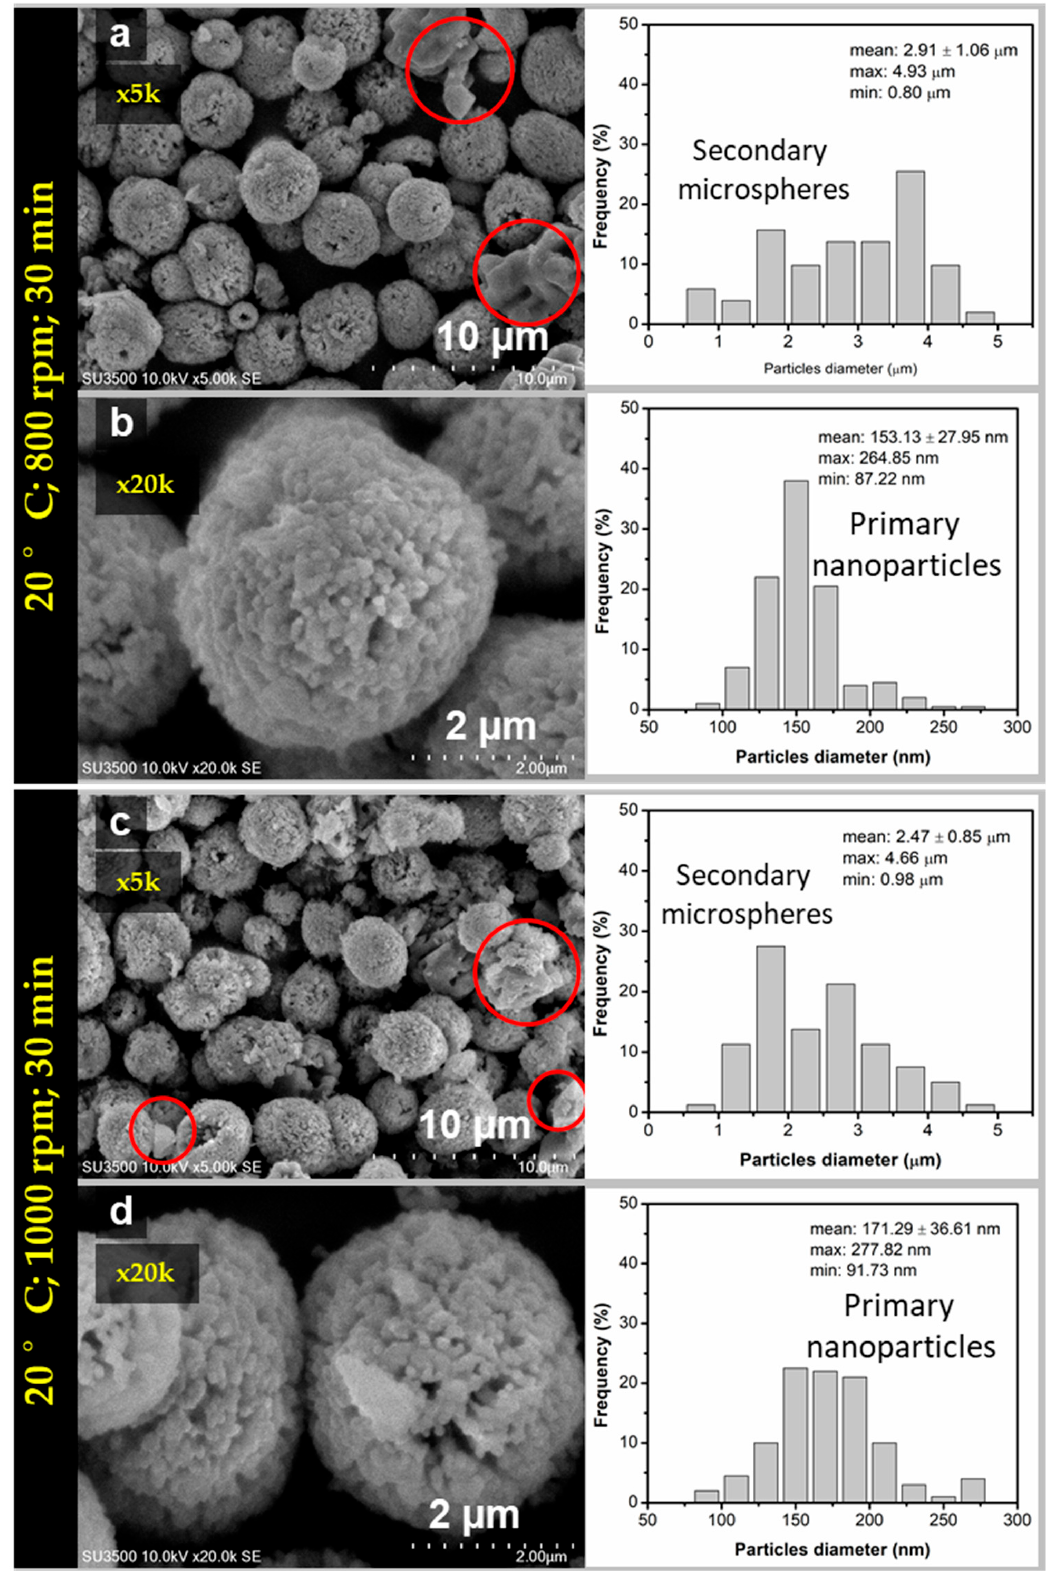
Figure 4. SEM images and particles size distribution of vaterite synthesized at 20 °C (time reaction 30 min) for different stirring speeds ( a , b ) 800 rpm and ( c , d ) 1000 rpm.